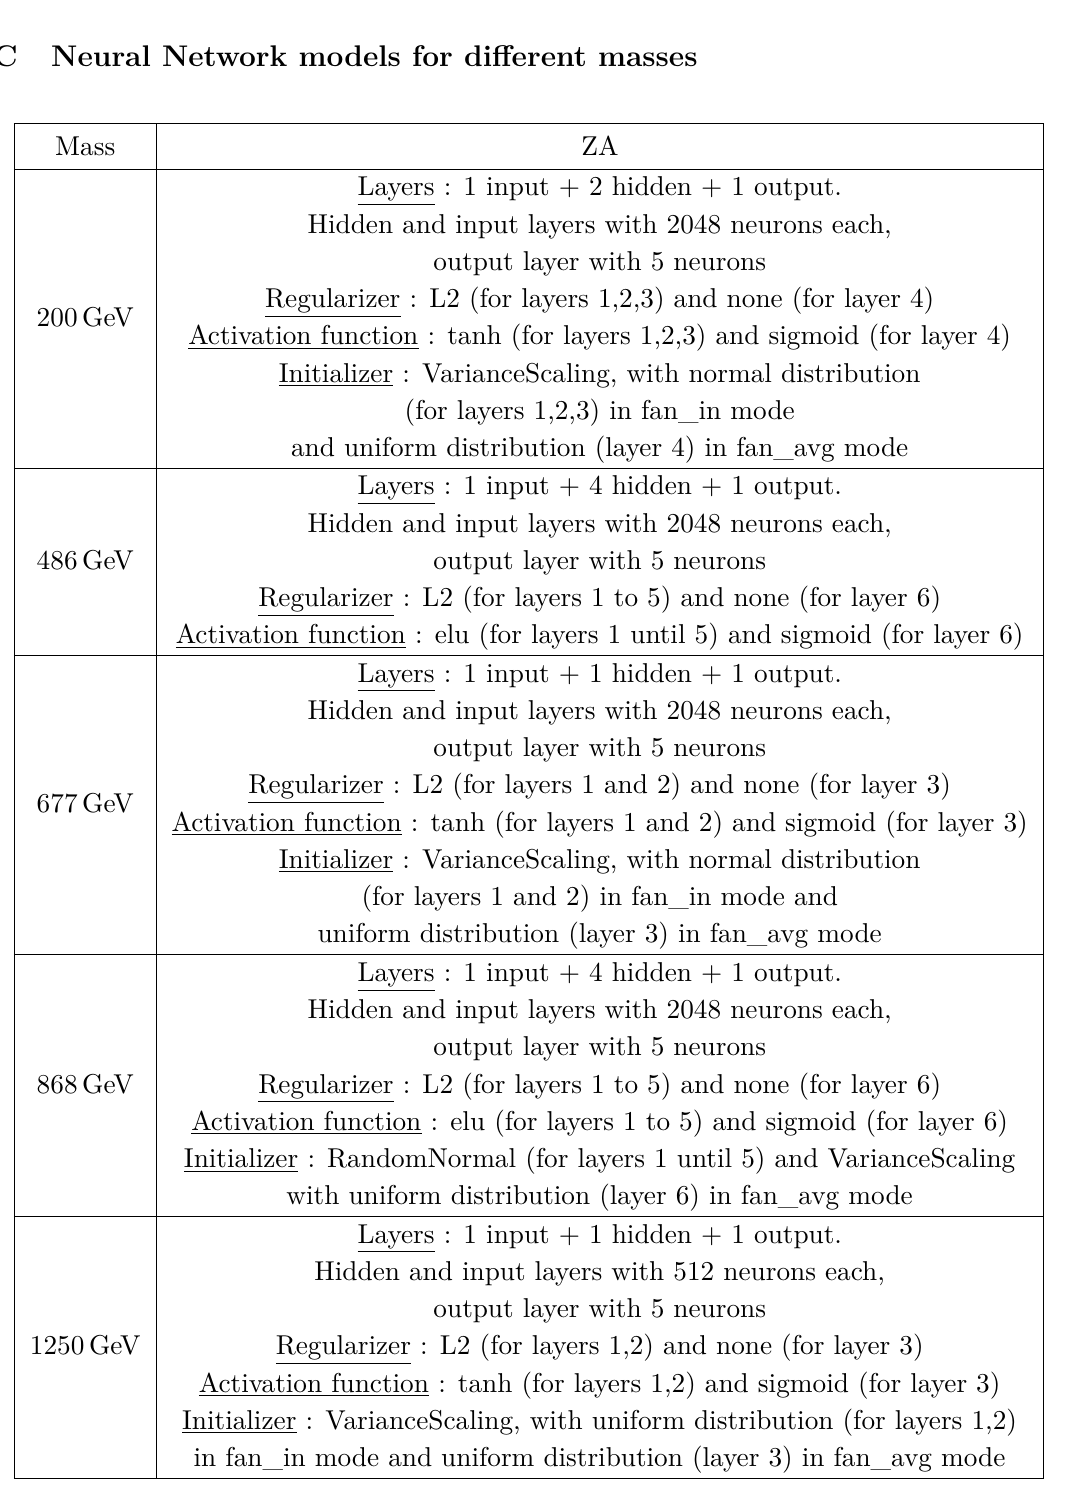
Table 10. Neural networks architectures employed for each mass of the lightest VLL for ZA channel. The architecture is determined following the implementation of an evolutive algorithm that maximizes the accuracy